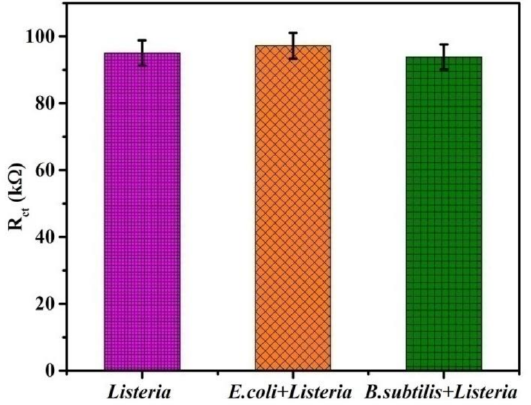
Figure 4. Impedance response of various bacteria indicating the selective nature of the developed